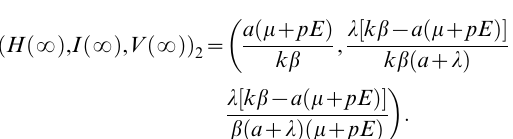
Figure 3d plots the final average antibody affinity U avg against the memory antibody affinity U 2 . Equation 7 ensures the monotonic increase of U 1 , whereas the increase rate of U 1 indirectly depends on U 2 . Similar to Figure 3c, a plateau with U avg w 0 : 9 exists when U 2 v 4 : 0 | 10 { 3 , and U avg decreases substantially from 0.82 to 8 : 8 | 10 { 3 when U 2 increases from 5 : 3 | 10 { 3 to 8 : 7 | 10 { 3 . Note that in Figure 3c, this sudden decrease in the cumulative effect of naı¨ve antibodies X Int occurs in 1 the same region of U 2 . When U 2 w 8 : 7 | 10 { 3 , U avg increases approximately linearly with U 2 , which is mainly due to the contribution of the memory antibodies.